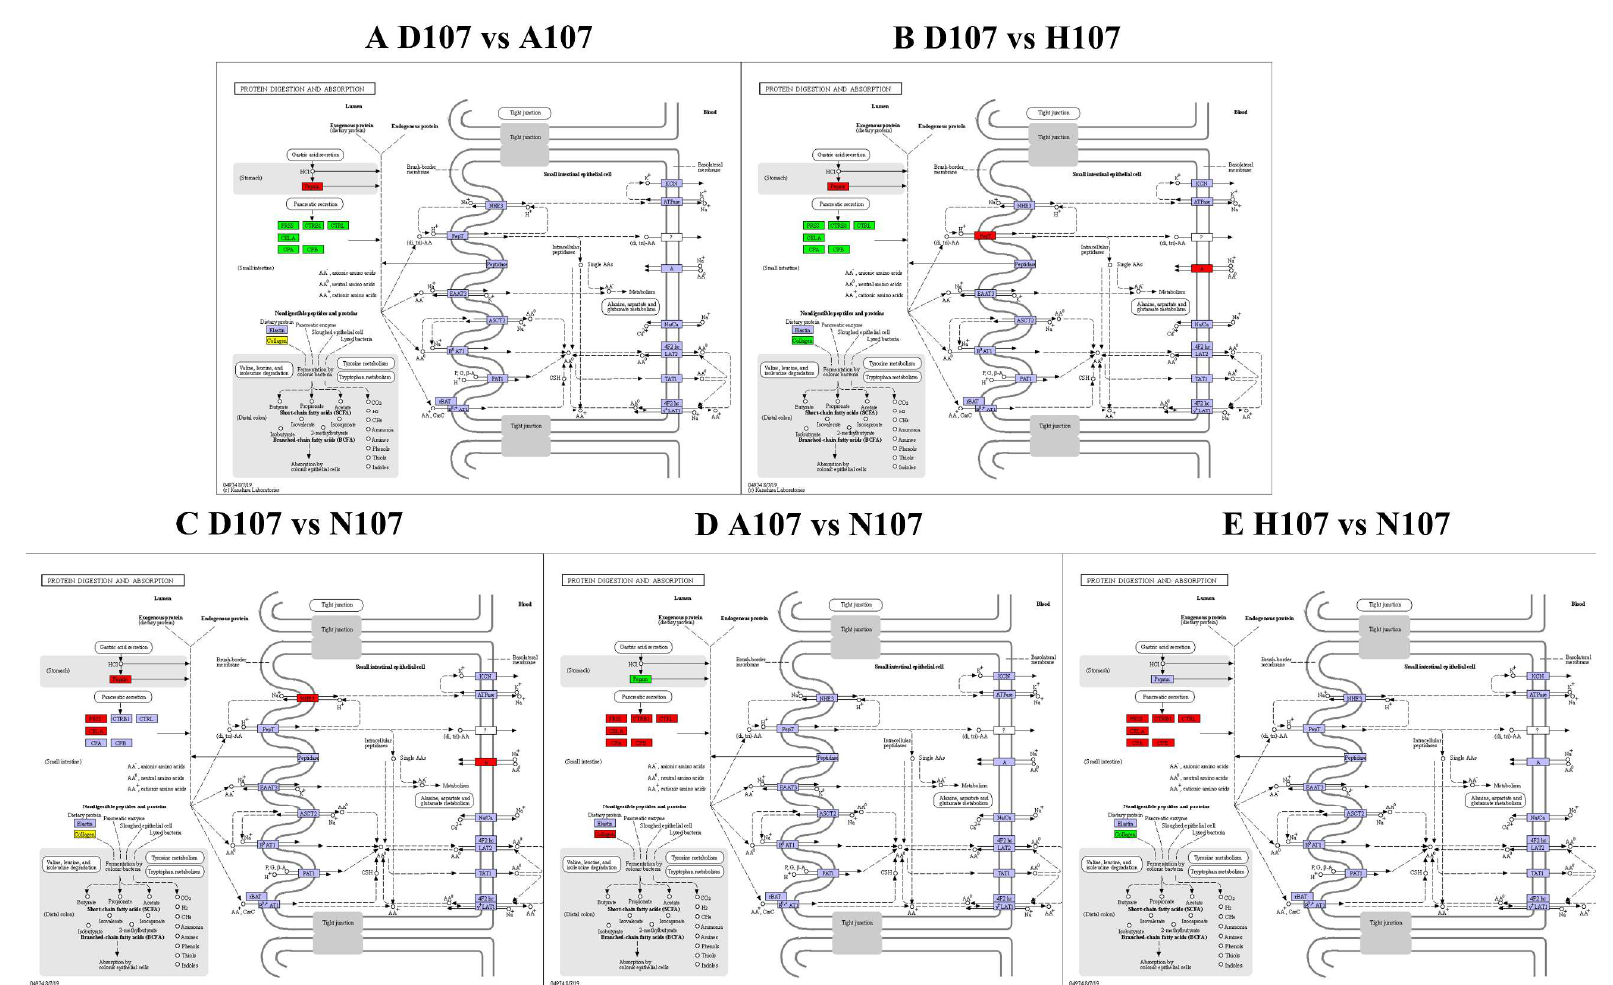
Figure 6. The ‘protein digestion and absorption’ pathway in KEGG was enriched under hypoxia and acidification stress.